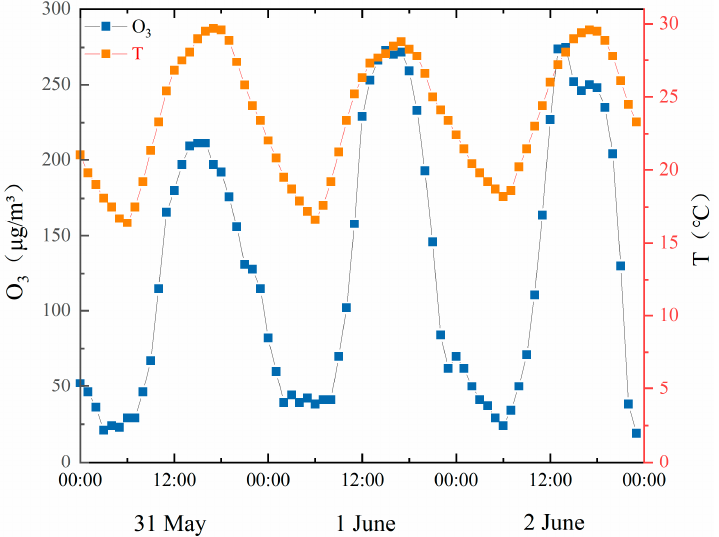
Figure 9. Variations of O3 concentration and air temperature in Taiyuan from 31 May to 2 June.